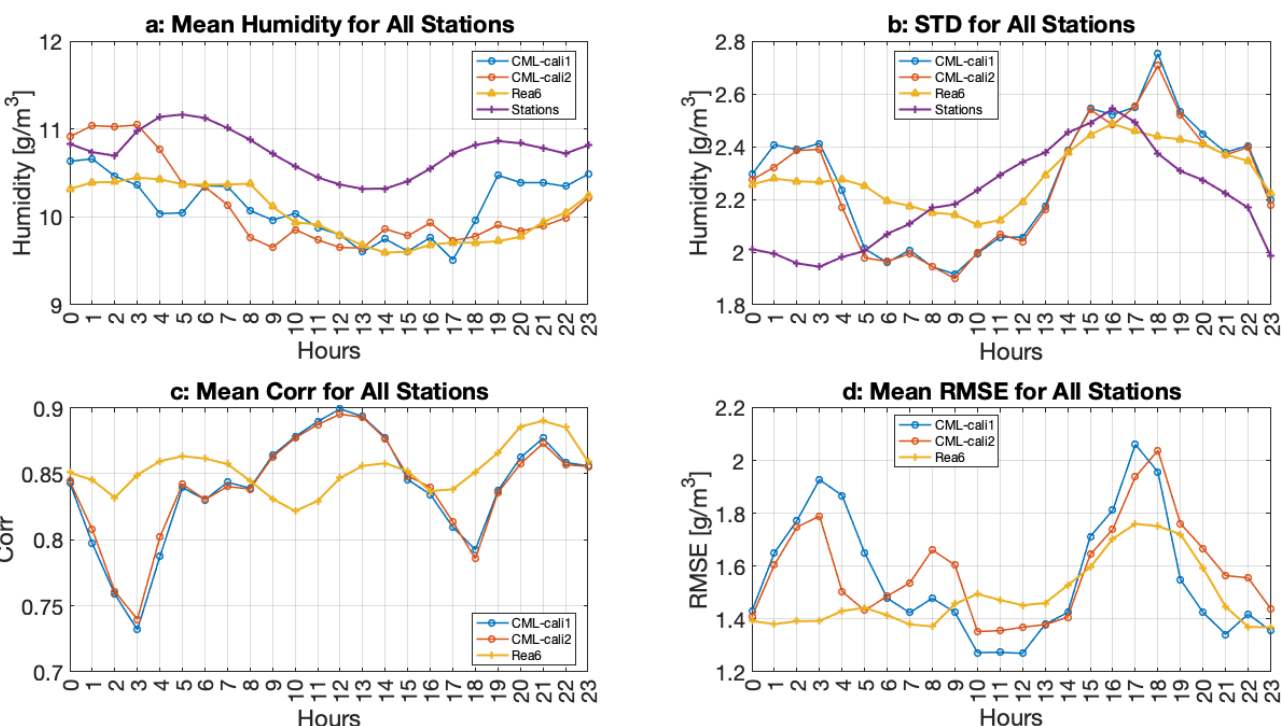
Figure 2. Mean correlations ( a ), RMSE ( b ), mean absolute humidity values ( c ), and STD ( d ) for all stations with full available data when applying 24 h intervals for calibration and an effective radius for interpolation of 40 km (32 stations, mean elevation 271 m, STD-165 m). Two runs were performed: (1) with different equations for calibration at each hour of the day (blue, CML-HO-cali1) and (2) with the same equation for calibration for all the hours (red, CML-HO-cali2, see methodology). Results that refer to Rea6 are in yellow and those referring to weather stations (WS-HO) are in purple. Table 2. Averaged correlation, RMSE, mean and STD based on the cali2 method and comparisons at all the WSs locations. A comparison between reanalysis (Rea6) and CML-HO (cali2) based on the comparison to WS-HO. The values represent the averages for the whole period (June 2018) for each hour of the day, separately. The number in the first row (SUM#) indicates on the better results for each observation source. Other rows summarized the mean for all the hours (second row) and for different parts of the day (numbers refer to the local time). The better method, i.e., CML or Rea6, is indicated in blue.